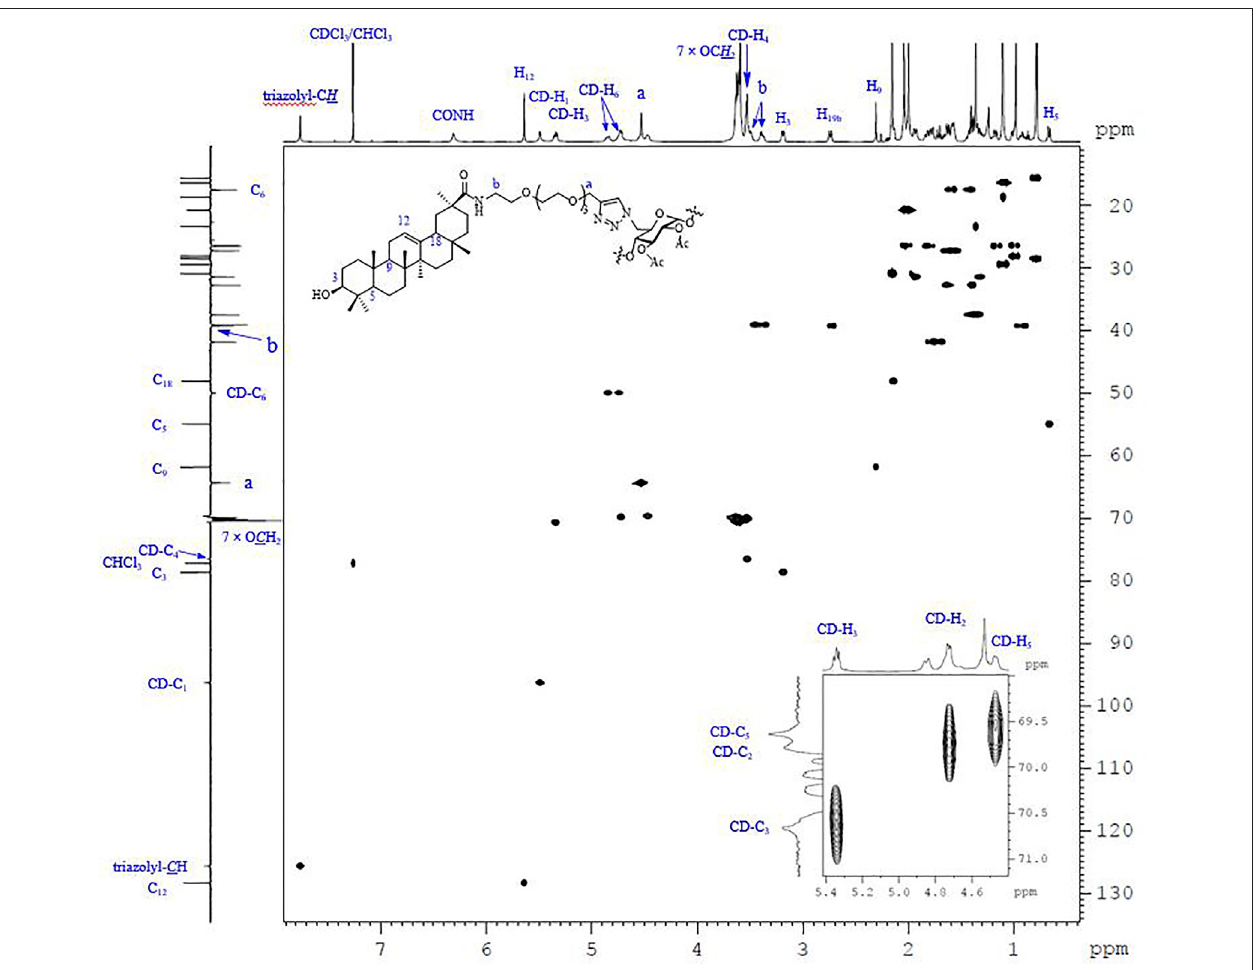
FIGURE 3 | The 600 MHz HSQC spectrum of 23 recorded in CDCl 3 at 298 K, with the 1D 1 H and 13 C NMR spectra along the top and the side, respectively.